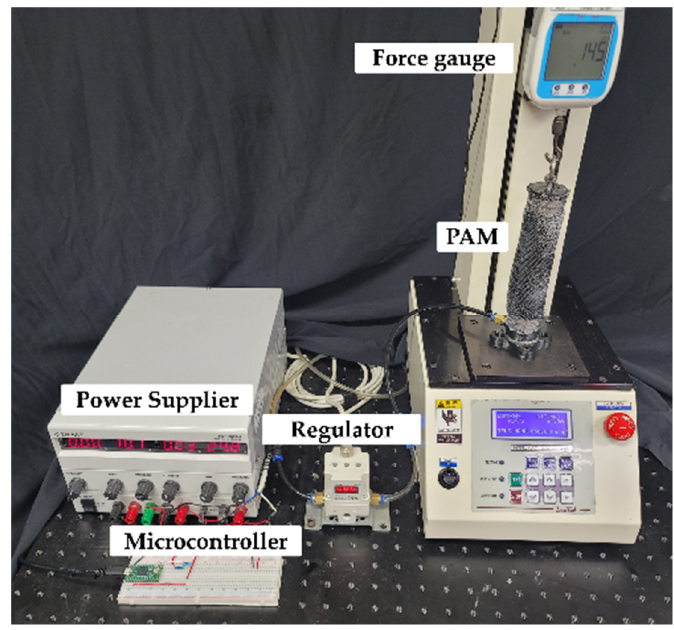
Figure 4. Testbed setup of the static contraction force experiment.